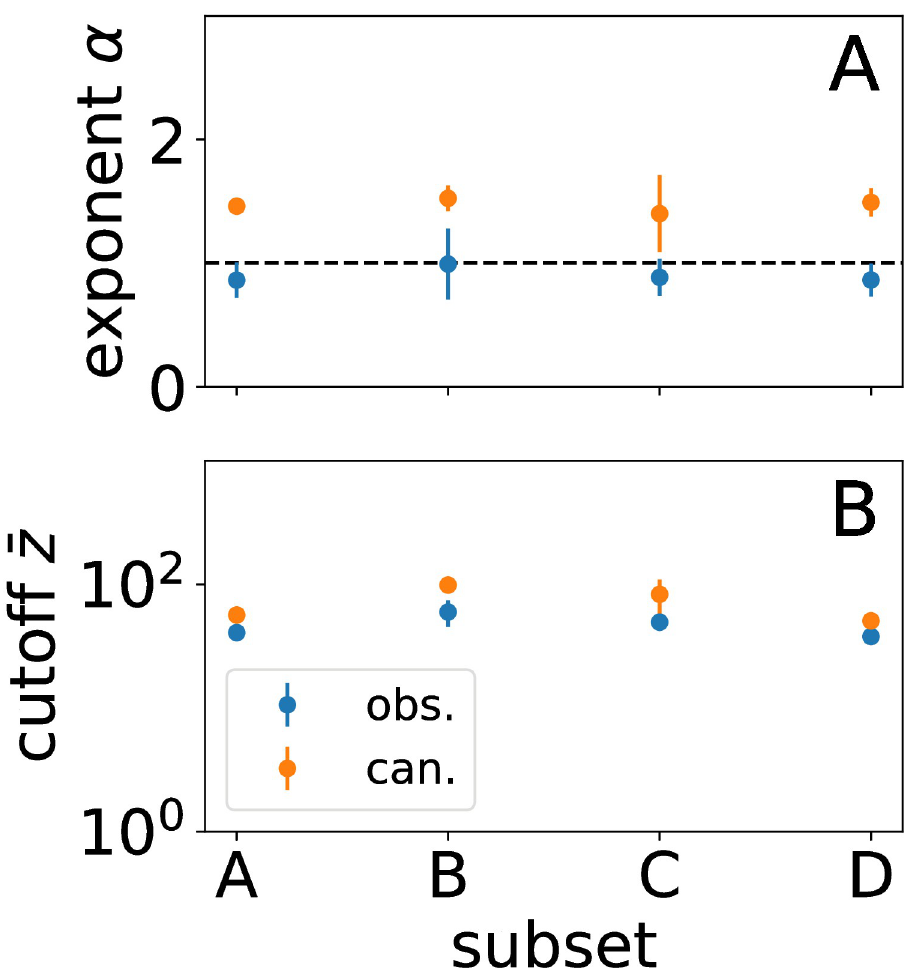
Fig 5. (A) Power law exponent from fitting FIM eigenvalue spectra comparing observable and canonical perturbations. (B) Exponential tail cutoff � z . See Fig F in S1 Text for another